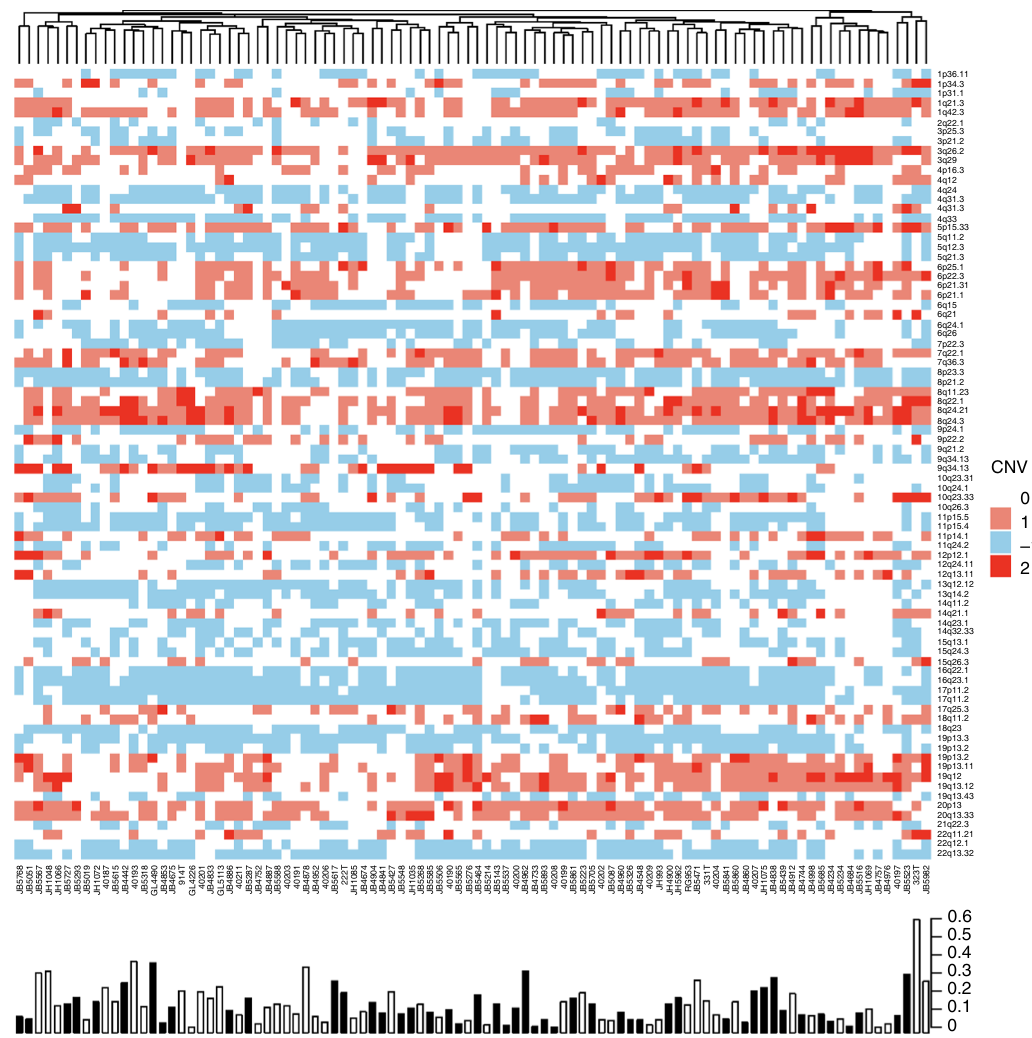
Fig. 2 Signi fi cant copy number alterations as identi fi ed by GISTIC. The proportion of genome signi fi cantly altered (homozygous deletion or 2+ fold ampli fi cation) is depicted in a bar plot along the bottom. The presence of a STIC lesion is indicated by a black bar in the bar